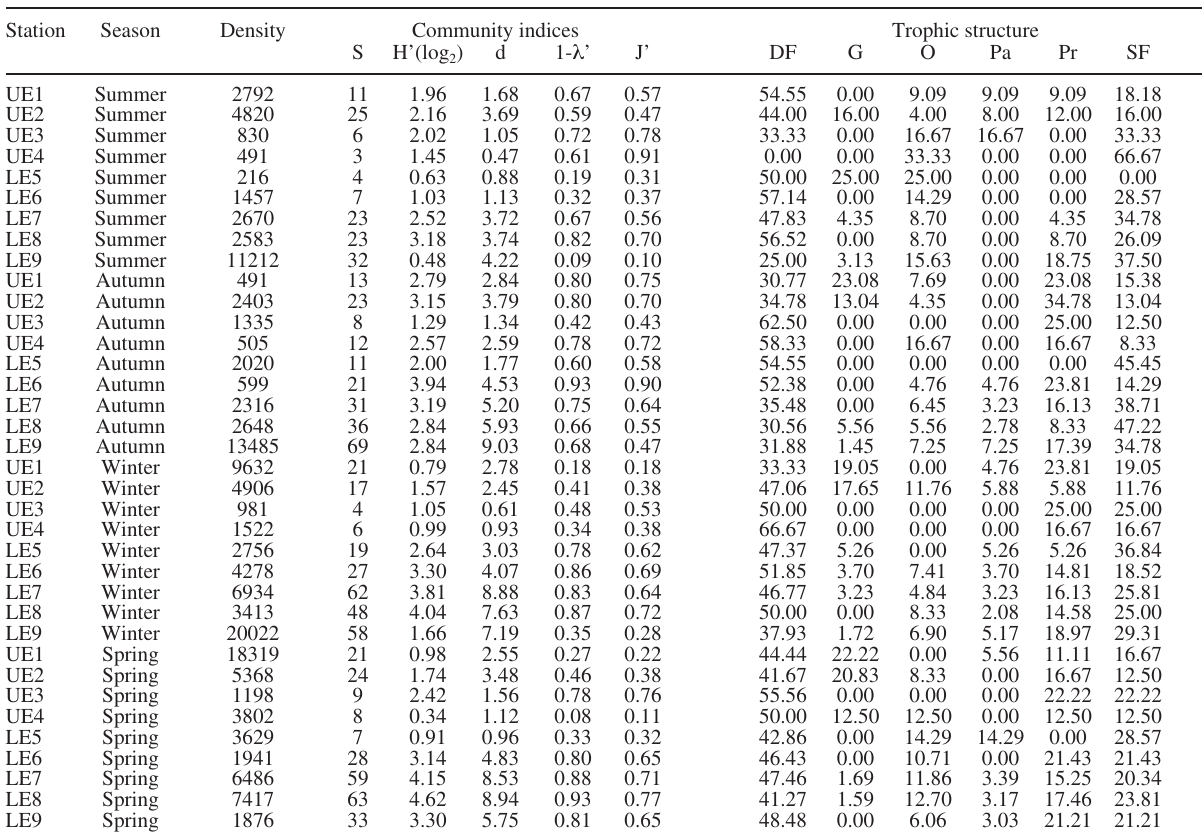
Table 2. – Community descriptive parameters for each sampling station and season. N, total abundance per 0.14 m 2 ; D, density (ind m -2 ); S, richness;